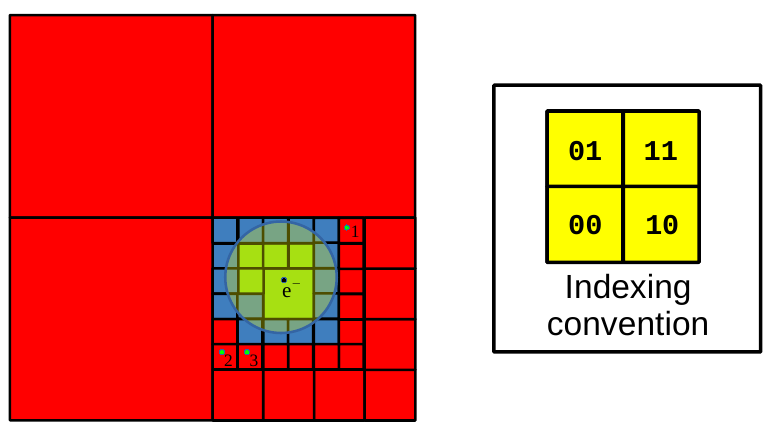
Figure A1. Illustration for recursive division of 2D volume into a Barnes-Hut tree. Each square can be subdivided into four smaller squares. These subdivisions form nodes of the tree. Each subdivision can be identified by two bits xy (as seen on the right plot), with values indicating in which of the four sub-squares the atom is located. For example, if the atom 1 is in the lower right square, it gets 10, as the most significant pair. After the next division, it obtains the index 11 etc. In the four-level tree, the atom 1 gets the 8-digit binary identification number 10 | 11 | 01 | 11. Similarly, the atom 2 gets 10 | 00 | 01 | 00, and the atom 3 gets 10 | 00 | 01 | 10. Atoms and ions are potential candidates for getting ionized by the electron e, if they are located within a predefined distance d , visualized by the